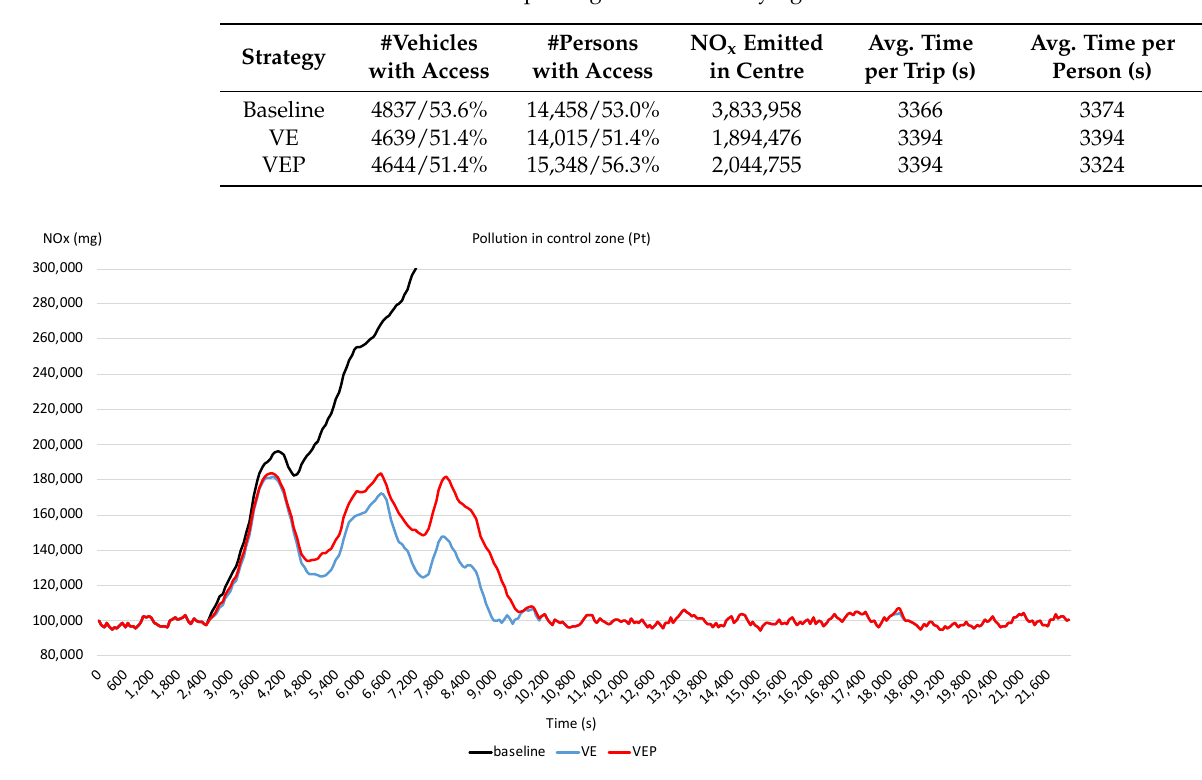
Table 2. Simulation results for parking access with varying arrival rates.